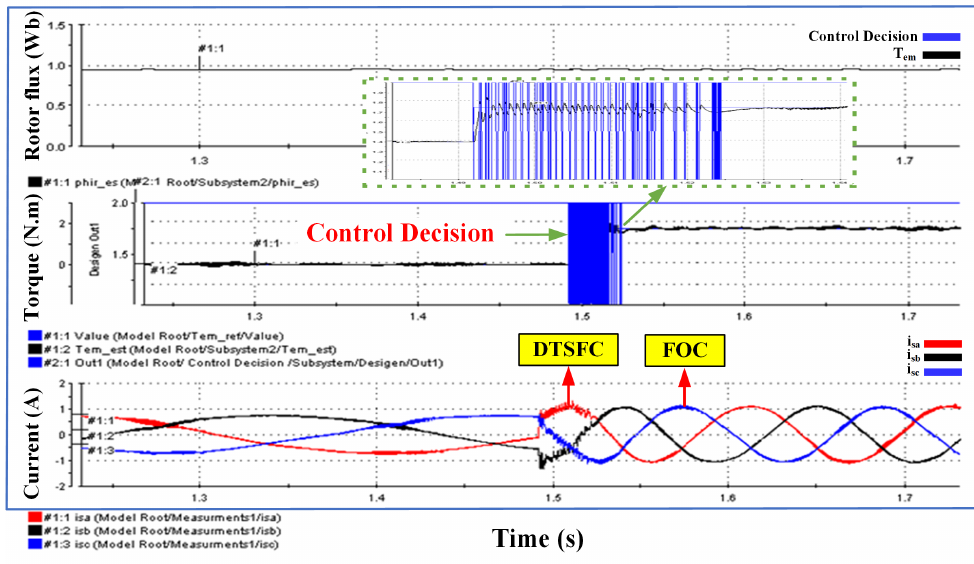
Figure 35. The performance of the proposed FOC-DTC at a speed value of 0.75 ω n .